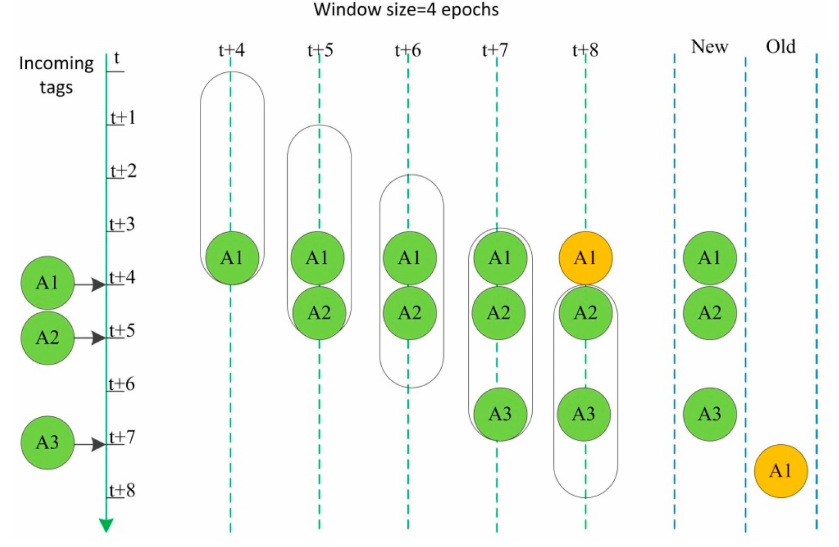
Figure 4. Sliding window